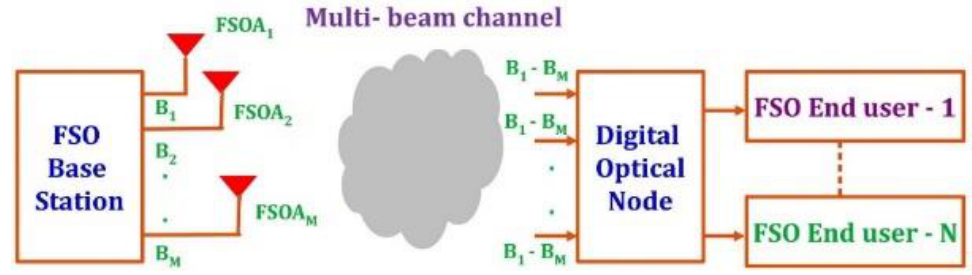
Figure 23. The DWDM-supported next-generation FSO network.